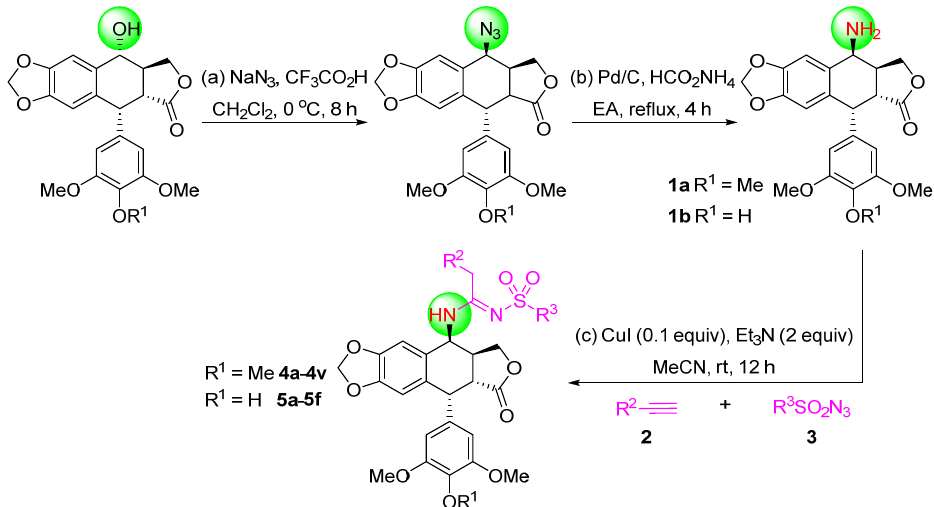
Table 1. The in vitro anti-proliferative activities (IC 50 , μ M) a of compounds 4a – 4v and 5a – 5f .